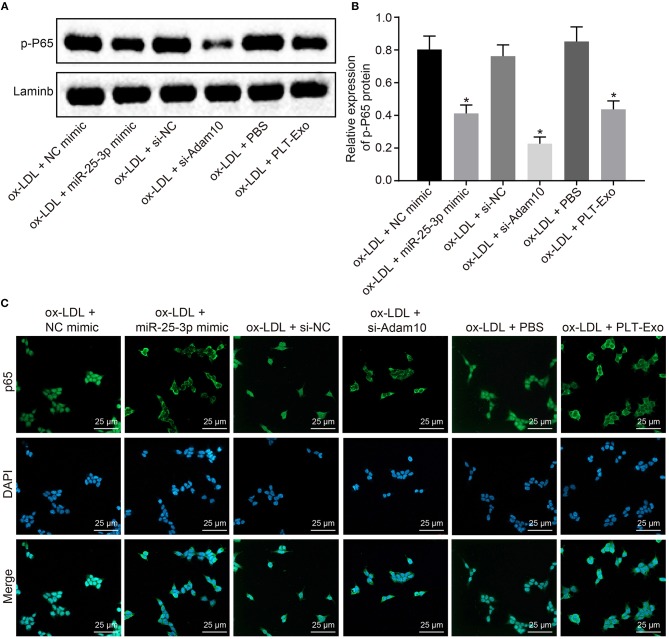
MiR-25-3p reduces CVEC inflammation reaction through the NF-κB signaling pathway. (A,B) Protein bands and levels of p-p65 in response to the treatment of ox-LDL + miR-25-3p mimic or ox-LDL + PLT-Exo, as determined by Western blot analysis. (C) p65 nuclear translocation in response to the treatment of ox-LDL, miR-25-3p mimic or PLT-Exo, as determined by immunofluorescence. *p < 0.05 vs. the ox-LDL + NC mimic (CVECs co-treated with ox-LDL + NC mimic) or the ox-LDL + PBS group (CVECs co-treated with ox-LDL + PBS). The measurement data are expressed as mean ± standard deviation and data among multiple groups were analyzed using one-way ANOVA. The experiment was repeated three times independently.